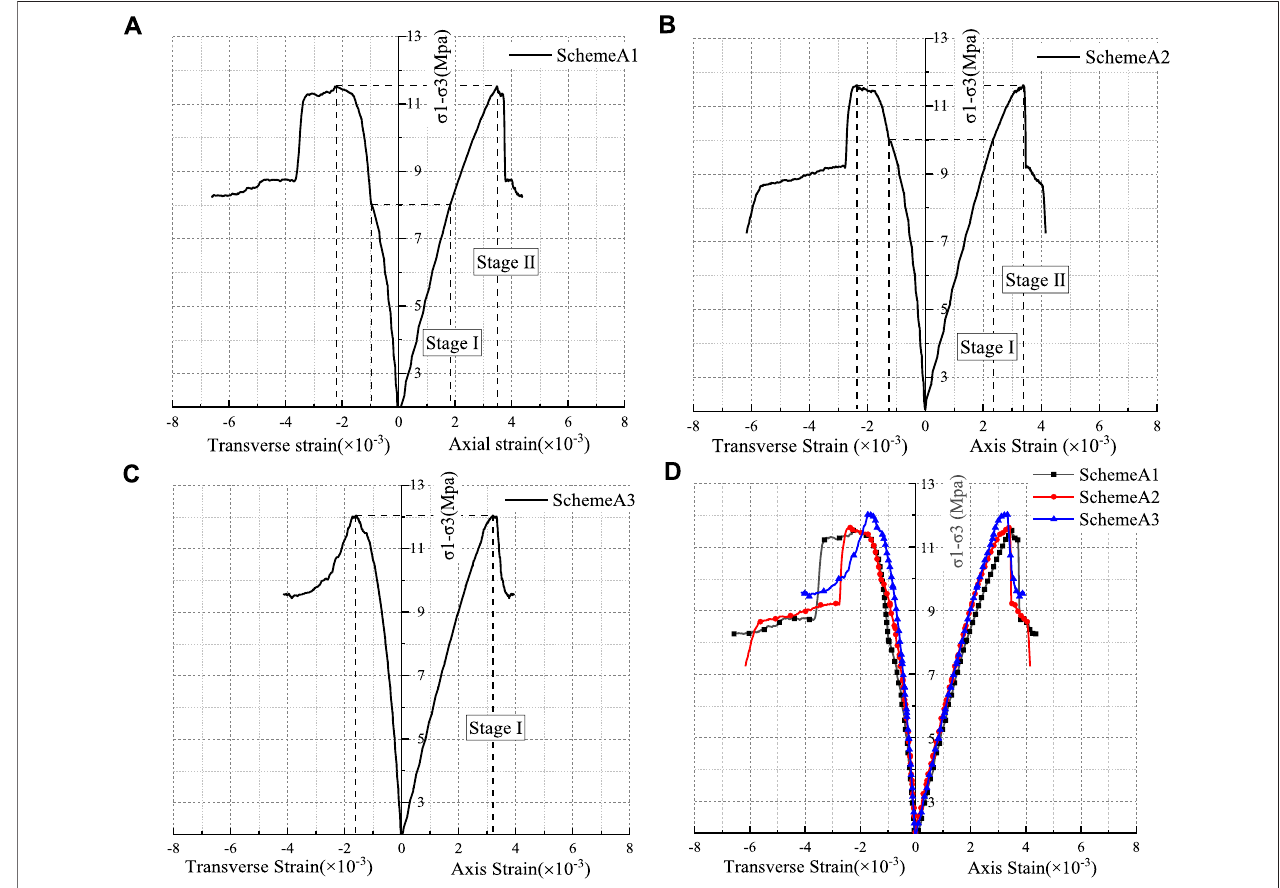
FIGURE5| DeformationcharacteristicsoftherockmassunderdifferentdepthandplanA. (A) LoadingschemeA1; (B) loadingschemeA2; (C) loadingschemeA3; and (D) comparative curves.